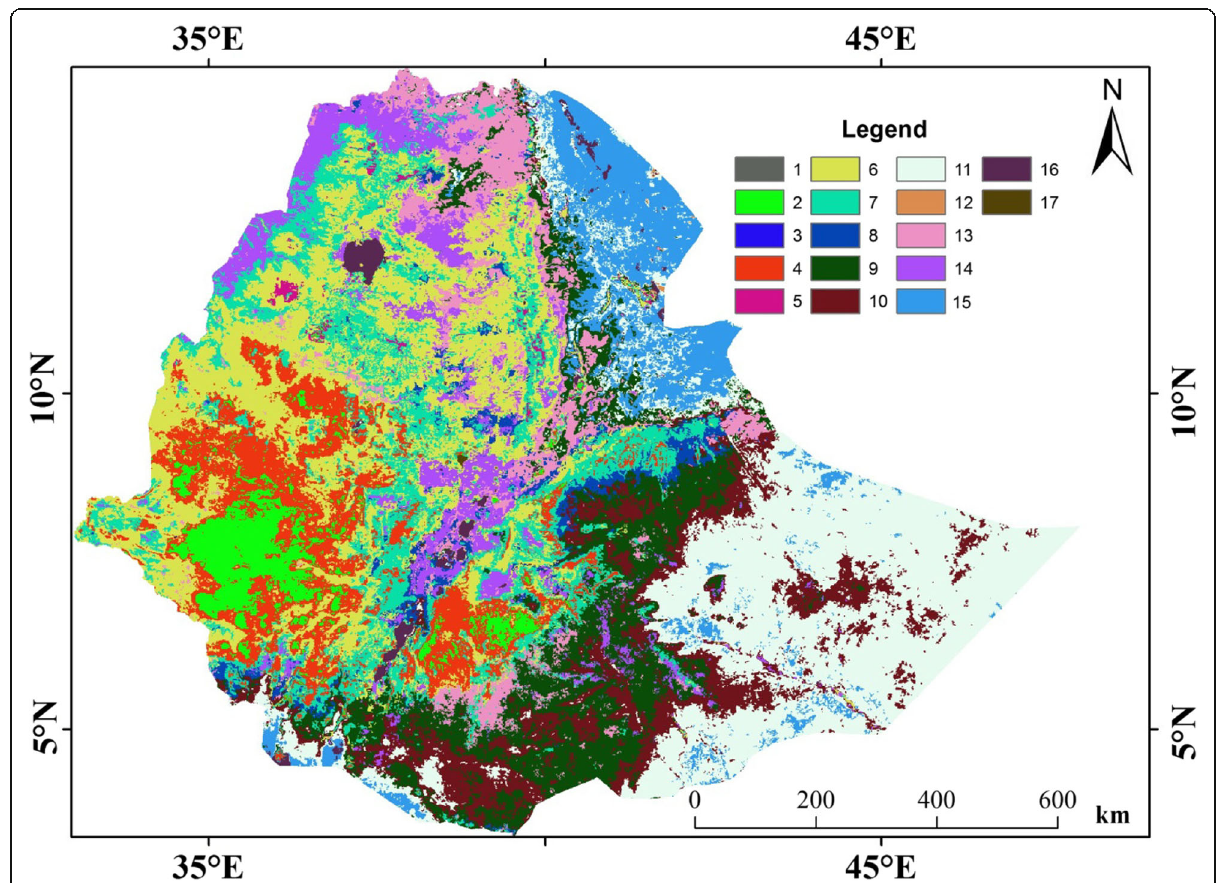
Fig. 2 Land cover map of Ethiopia (1: closed evergreen lowland forest, 2: montane evergreen forest (> 1000 m), 3 mangrove: 4: mosaic forest/ croplands, 5: mosaic forest/savanna, 6: deciduous woodland, 7: deciduous shrubland with sparse trees, 8: closed grassland, 9: open grassland with sparse shrubs, 10: open grassland, 11: sparse grassland, 12: swamp bushland and grassland, 13: croplands (> 50%), 14: croplands with open woody vegetation, 15: bare soil, 16: waterbodies, 17: cities)